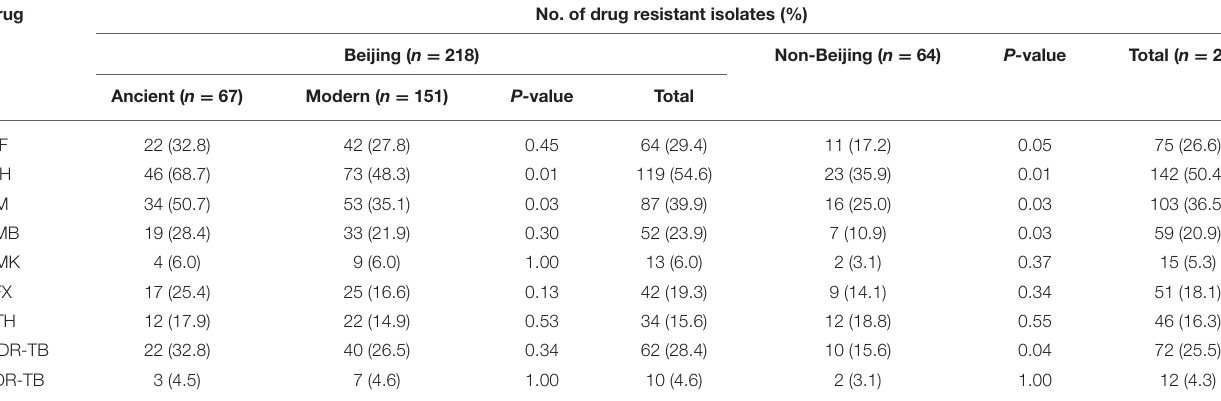
TABLE 4 | Distribution of drug resistant MTB isolates among Beijing and non-Beijing genotypes. Drug No. of drug resistant isolates (%) Beijing ( n =